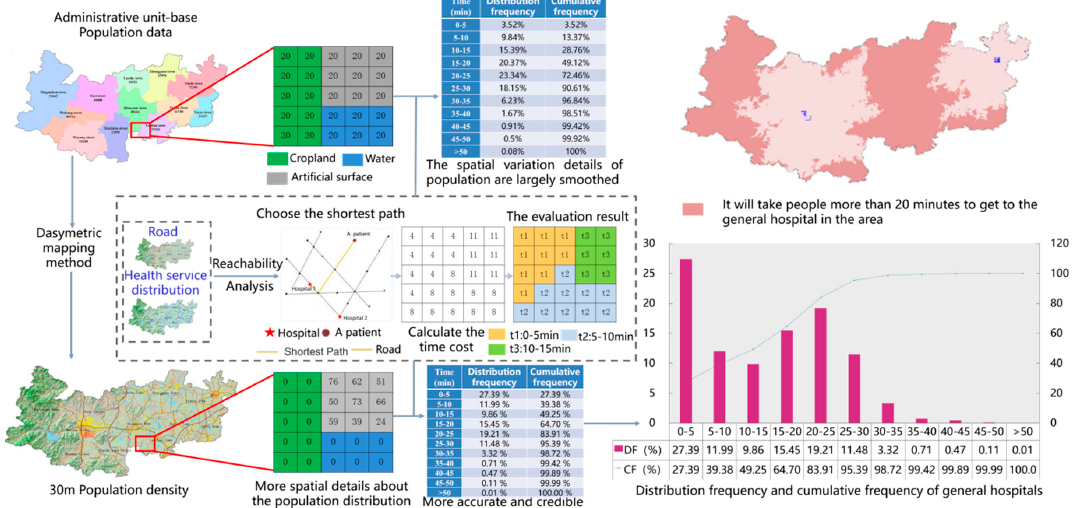
Figure 5. Deriving indicator 1.4.1 with a geospatially disaggregated